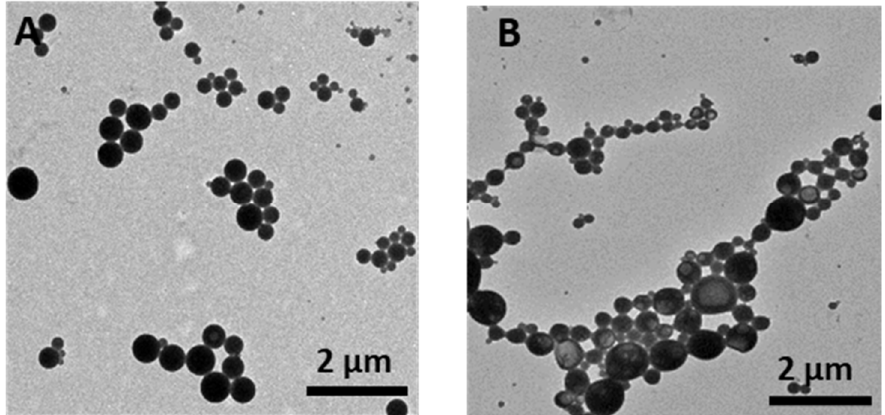
Figure 2. Typical TEM images of NPs prepared by double-emulsion using PLGA 15 C: ( A ) empty and ( B ) Table 1. VCM encapsulation in NPs with different polymer compositions, effect on DL, EE, mean diameter, PDI, and Zeta potential. PLA and PLGA (co)polymers from EXPANSORB ® were used.